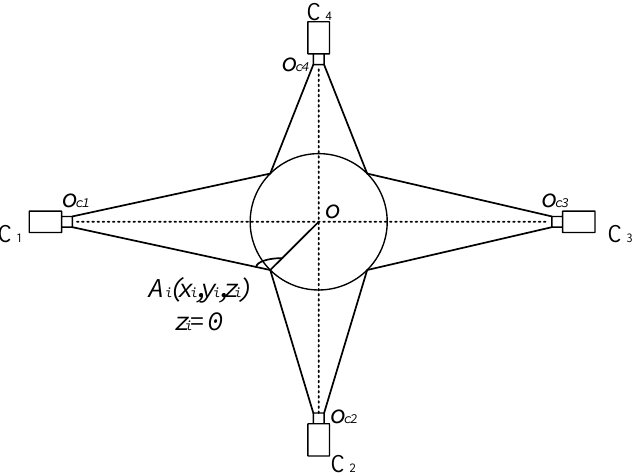
Figure 9. The best view of cameras for the bottle cap.